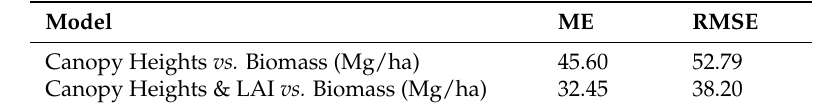
Table 3. Biomass estimation accuracy analysis ( n = 21).